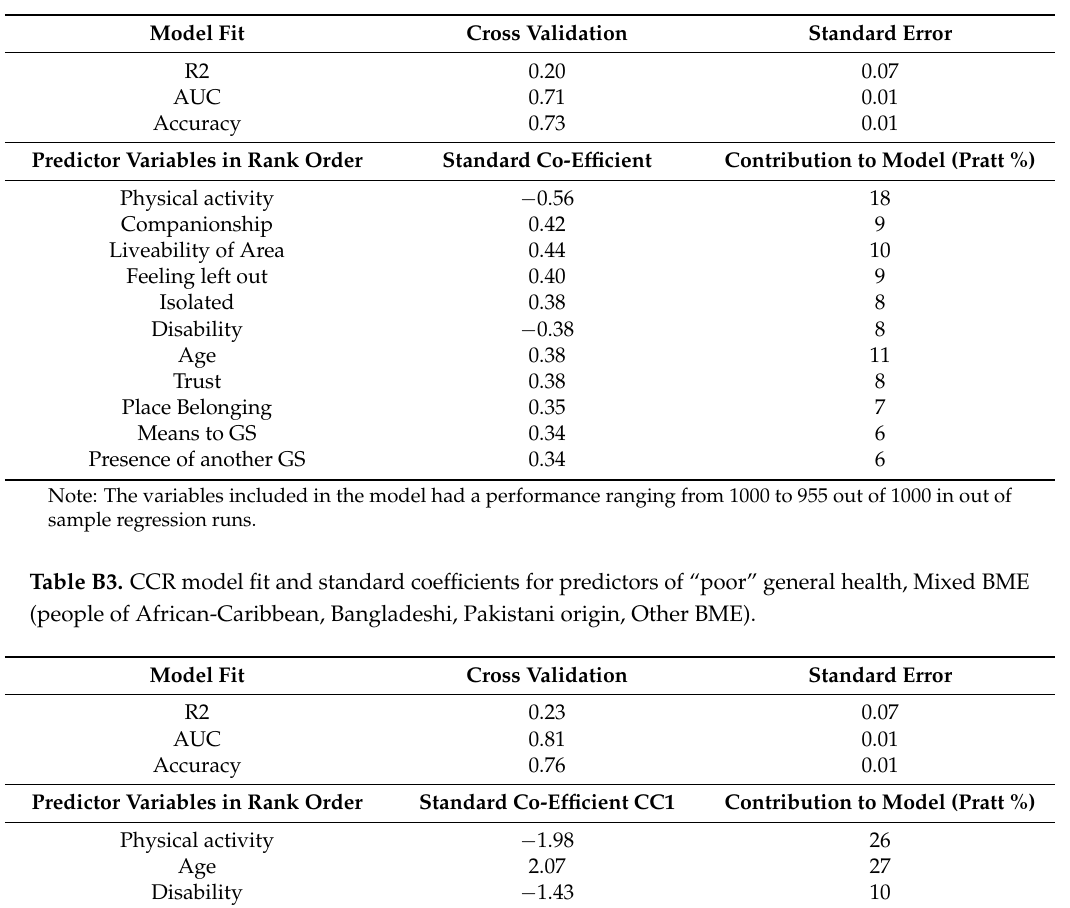
Table B2. CCRs model fit and standard coefficients for predictors of “good” general health, white British people.